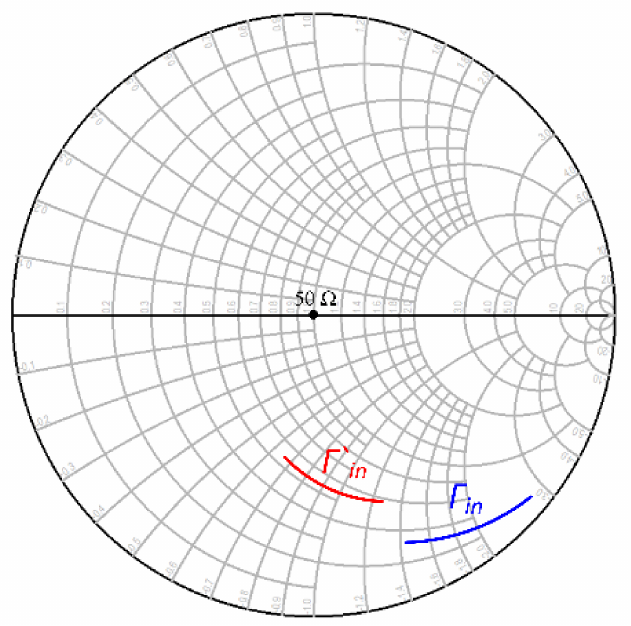
Figure 4. Γ in and Γ (cid:48) for a common-emitter (CE) common base emitter base collector (CBEBC) HBT. in